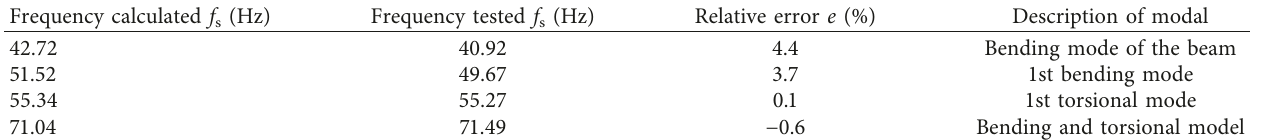
Table 1: Comparison of modal results of simulation and experiment.